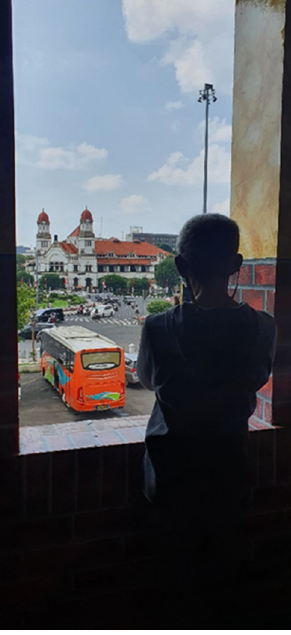
Figure 1: The view from Museum Mandala Bhakti in Semarang – the Tugu Muda roundabout and another recognised colonial building, Lawang